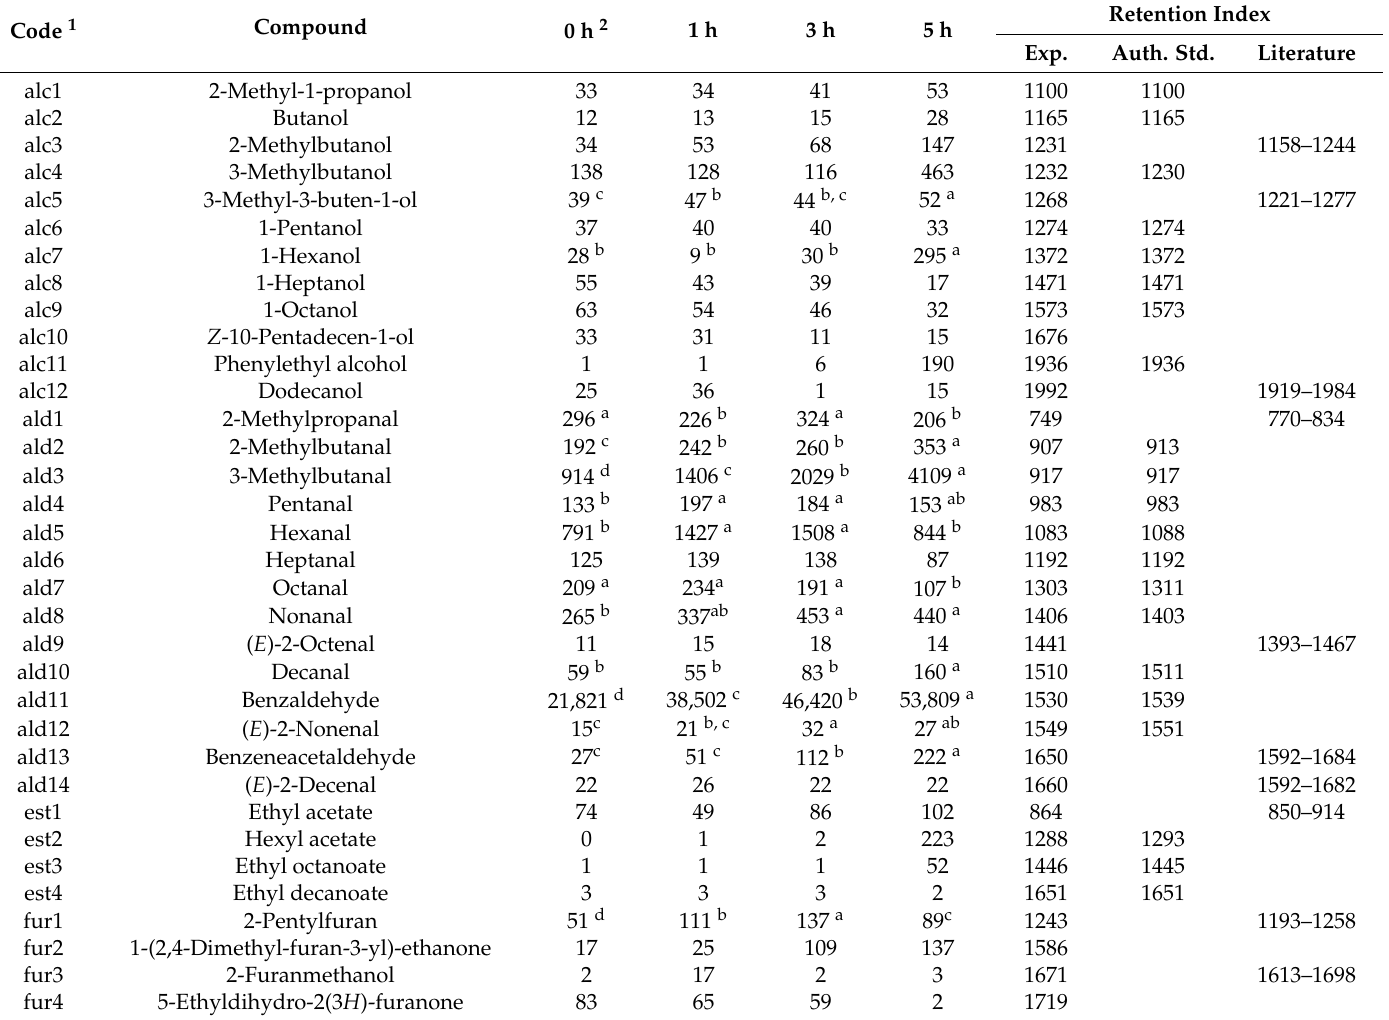
Table 2. Relative concentrations as peak area/1000 of volatile compounds detected during